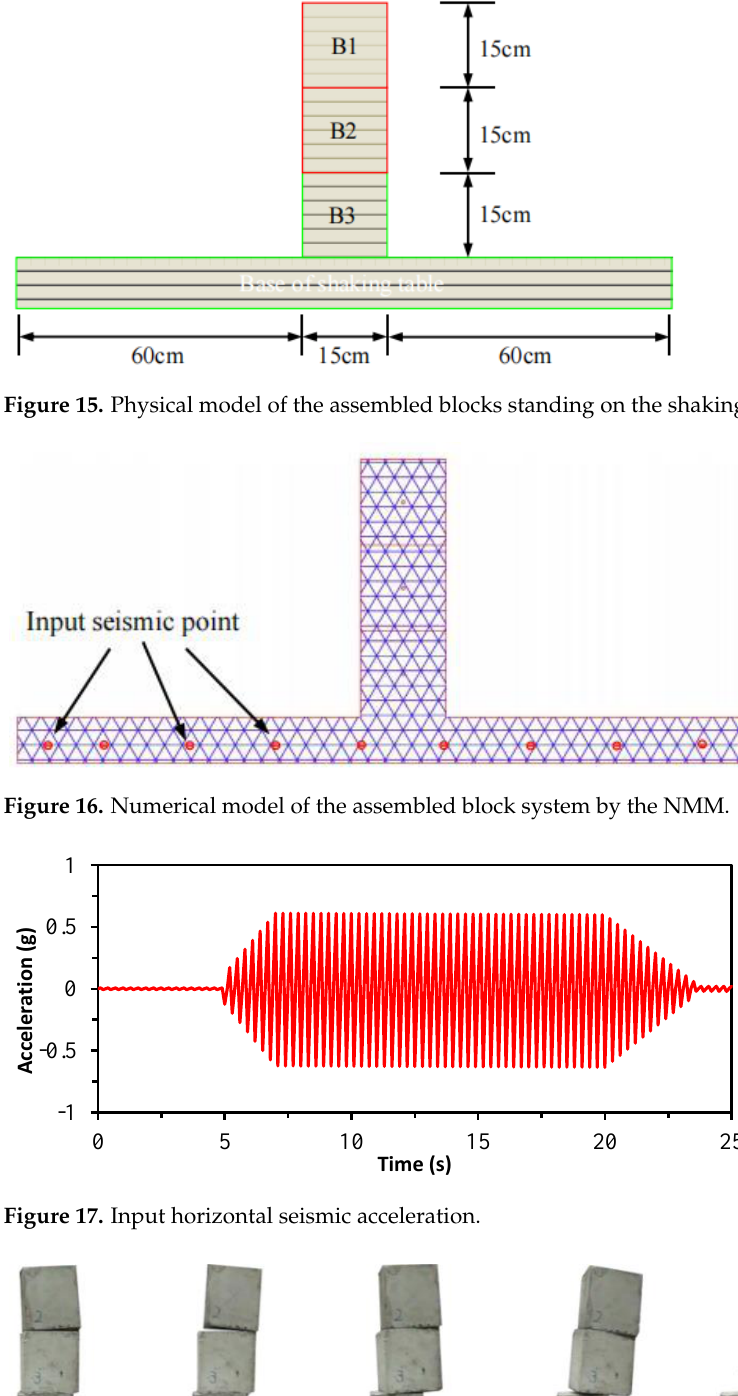
Figure 15. Physical model of the assembled blocks standing on the shaking table.